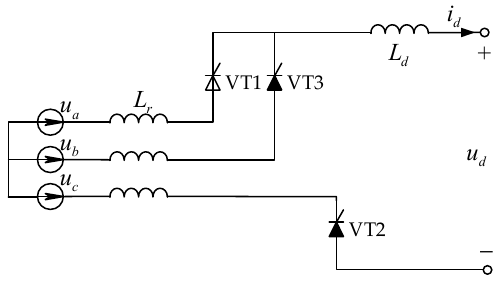
Figure 6. Equivalent circuit when valve 1 is turned off.